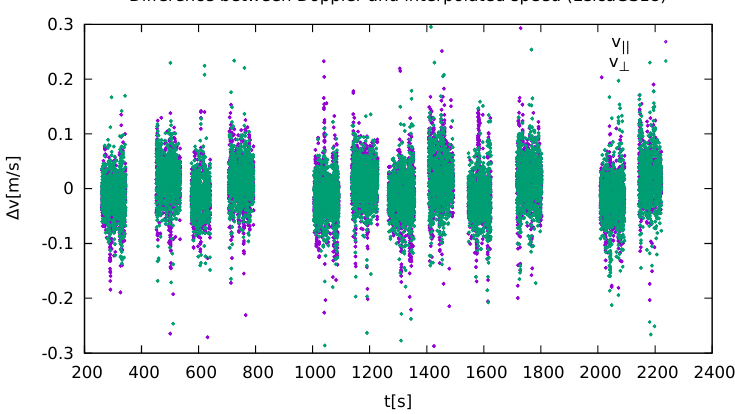
Figure 7. Interpolated velocity compared to the measured GNSS Doppler measurements in the Figure 7. Smoothed velocity data compared to the measured GNSS Doppler measurements in the parallel and perpendicular directions with respect to the road (own study). parallel and perpendicular directions with respect to the road (own study).